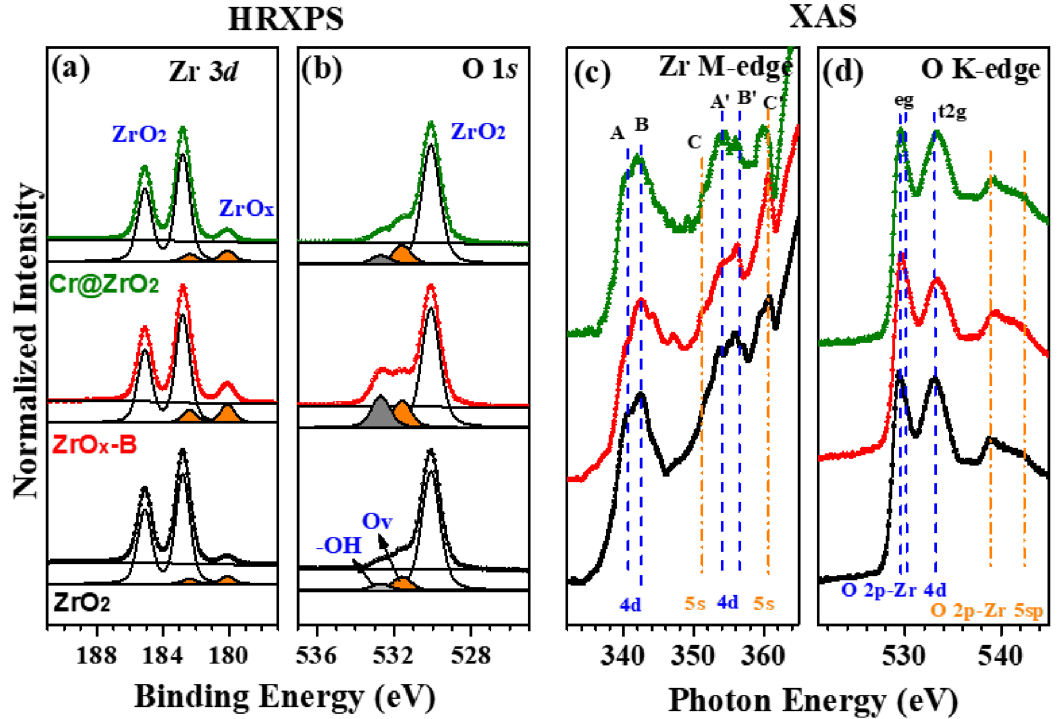
Figure 3. ( a ) Zr 3 d and ( b ) O 1 s core-level HR-XP spectra and ( c ) Zr M -edge and ( d ) O K -edge X-ray absorption spectra of ZrO 2 (bottom), ZrO 2 -B (middle), and Cr@ZrO 2 (top)